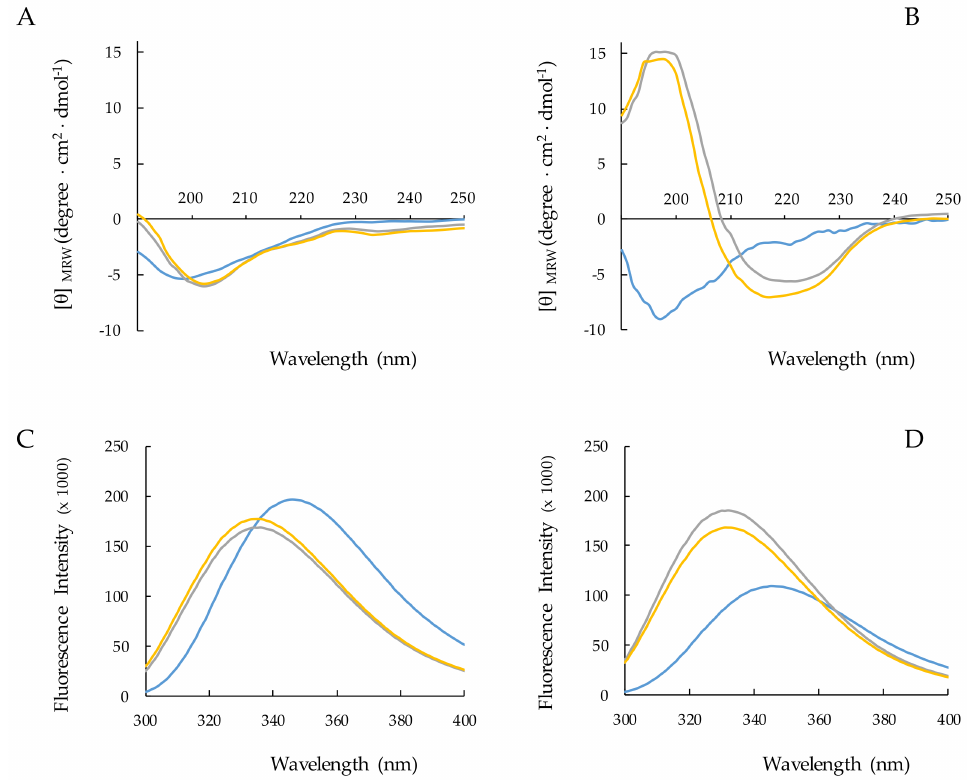
Figure 3. CD and fluorescence spectra of RiLK1 and 1018-K6. RiLK1 ( A , C ) and 1018-K6 ( B , D ) were analyzed at increasing SDS concentration. Spectra were recorded at peptide concentration of 50 µ M, pH 4.0 and 25 ◦ C in the absence of SDS (blue lines) and in the presence of SDS 50 mM (gray lines) or 150 mM (yellow